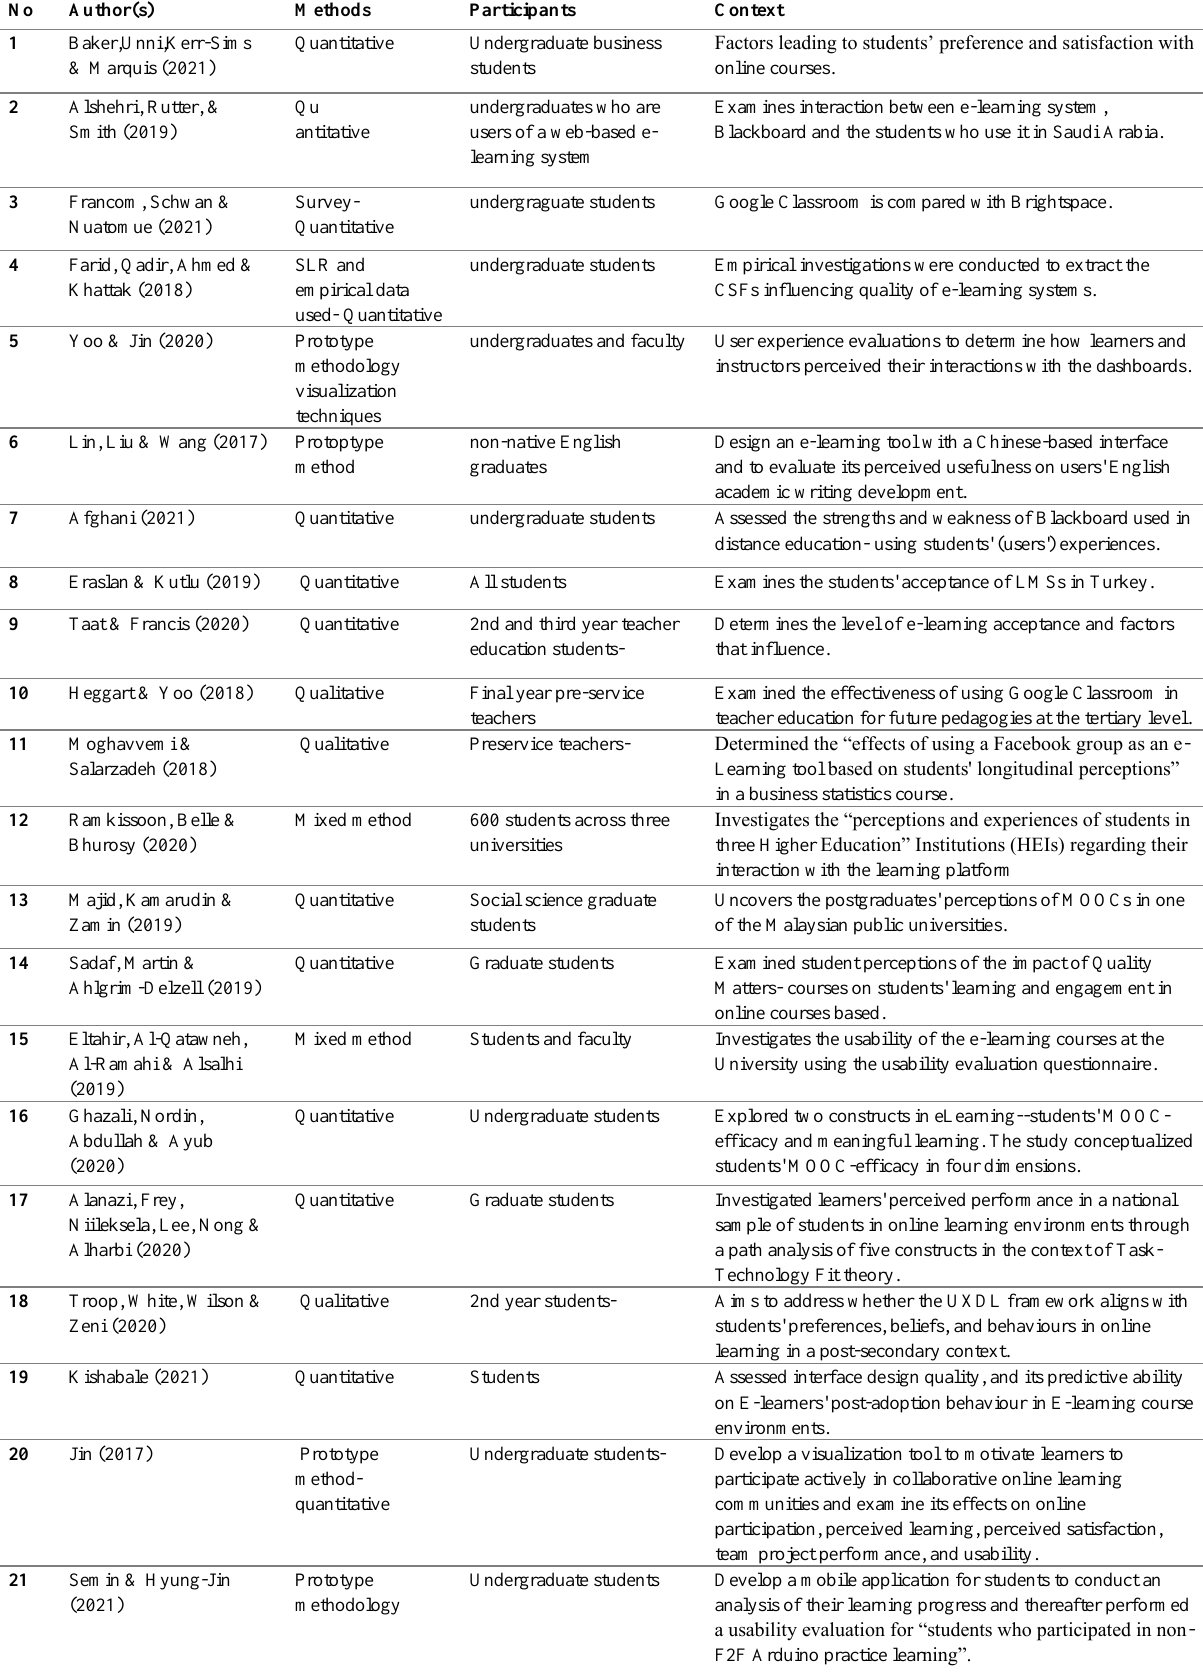
Table 1: Summary of Studies for